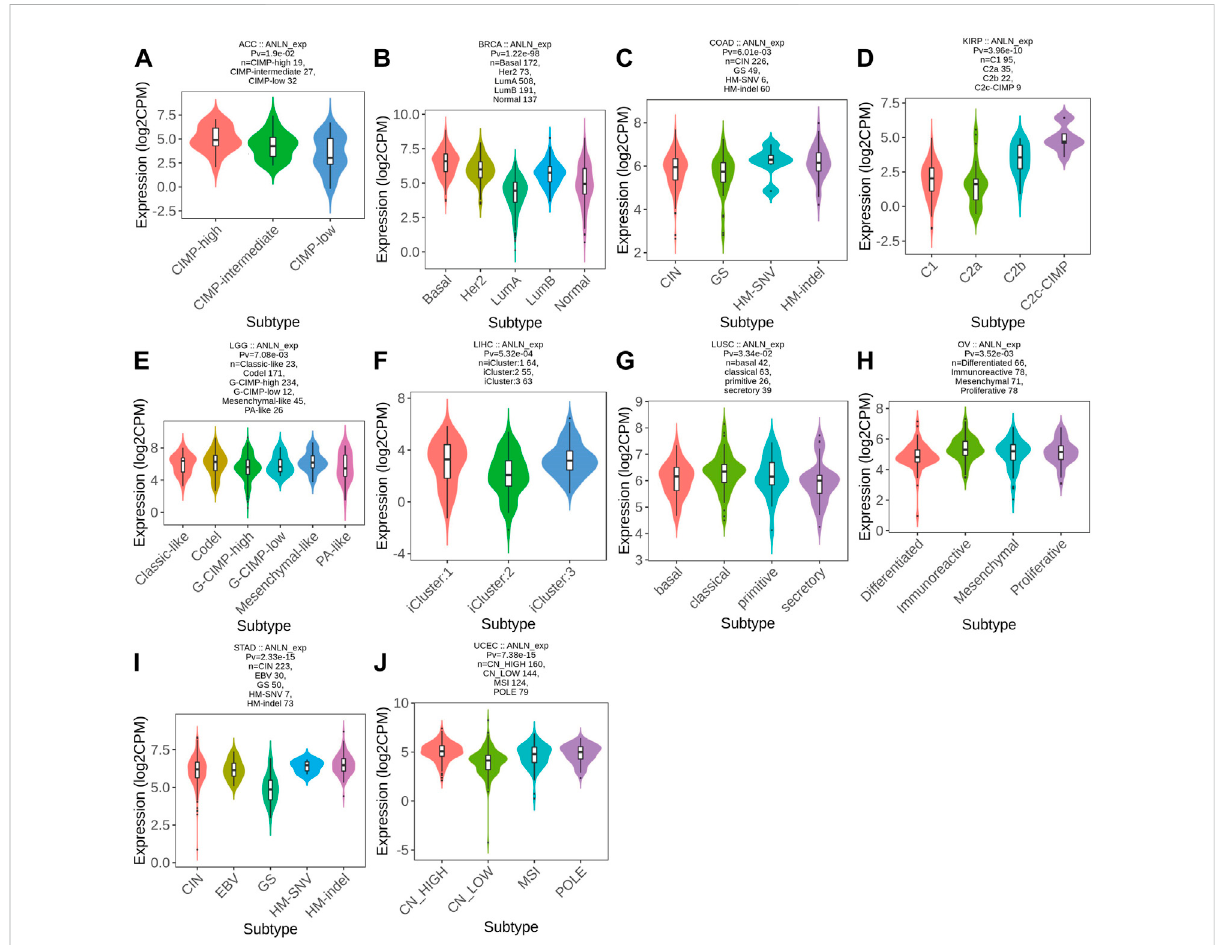
FIGURE 12 CorrelationsbetweenmolecularsubtypesandANLNexpressionacrossTCGAtumors. (A) ACC; (B) BRCA; (C) COAD; (D) KIRP; (E) LGG; (F) LIHC; (G) LUSC; (H) OV; (I) STAD; (J)